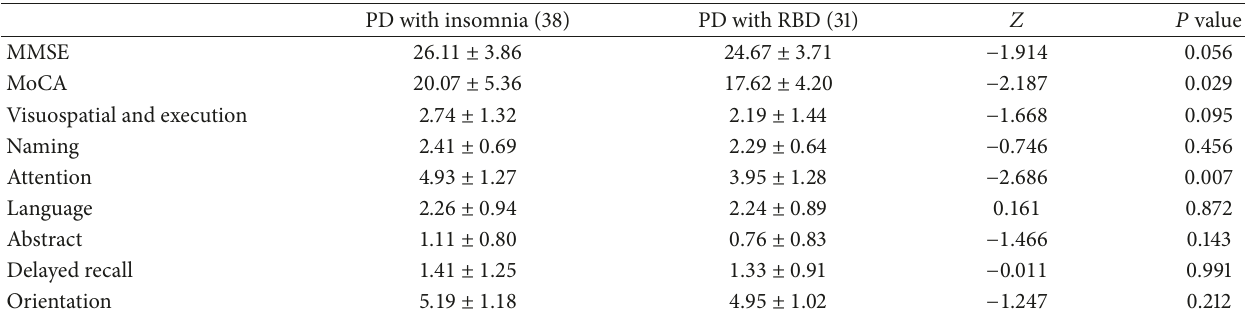
Table 5: Cognitive function characteristic analysis comparing two subtypes of